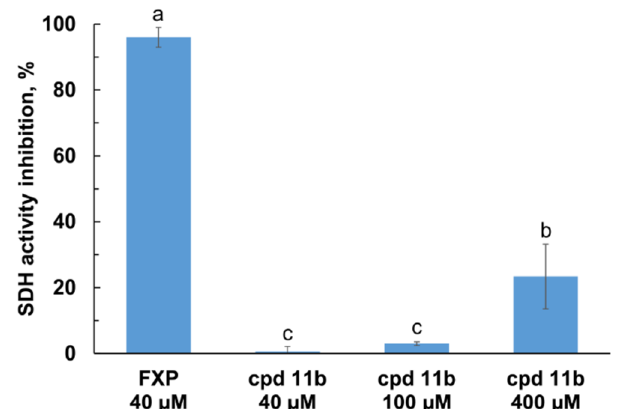
Figure 4. Effect of compound 11b on the P. oryzae mitochondrial SDH activity. To evaluate the percent of inhibition due to the SDHI action, the rates of the succinate:2,3-dimethoxy-5-methyl- p -benzoquinone dehydrogenase activity of the mitochondrial fraction were measured at 25 °C (λ = 595 nm) using DCPIP in the presence of 11b and the reference compound, fluxapyroxad (FXP), at the indicated concentrations. Data represent the mean ± standard deviation of at least three independent trials. Different superscript letters indicate statistically significant differences (Tukey HSD, P ≤ 0.01). Fluxapyroxad showed > 90% inhibition of SDH activity at the concentration of 40 µM.